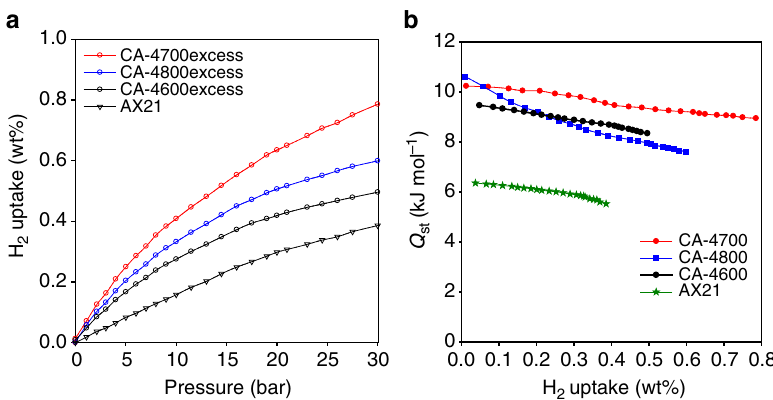
Fig. 8 Room temperature hydrogen storage capacity and isosteric heat of hydrogen adsorption. a Gravimetric excess hydrogen uptake at 25 °C of the CA- 4T-activated carbons derived from cellulose acetate and a commercially available activated carbon AX21, and b isosteric heat of hydrogen adsorption ( Q st ) as a function of hydrogen uptake for the CA-4T activated carbons derived from cellulose acetate and a commercially available activated